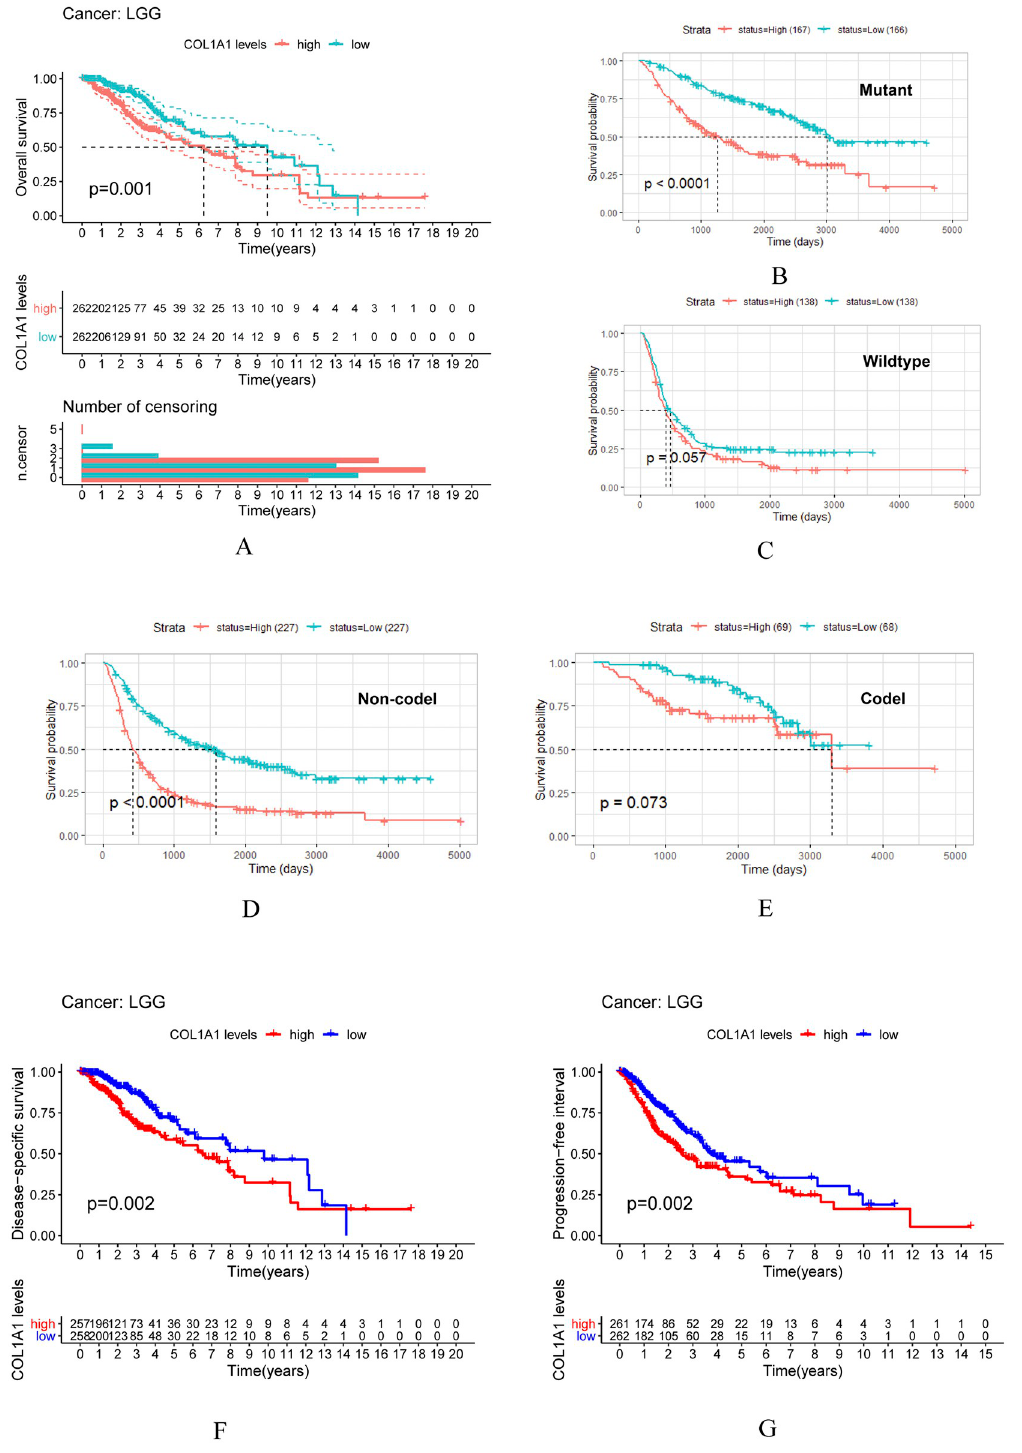
Fig 2. Overall survival curve of high and low expression of COL1A1 in glioma and it’s subclass. (A) Survival curves of OS by Kaplan-Meier respectively in LGG. (B-E) Survival curves of Survival probability in Mutant, Wildtype, Non-codel and Codel. (F-G) Survival curves of DSS and PFI in LGG. DSS, disease specific survival; PFI, progression free interval.